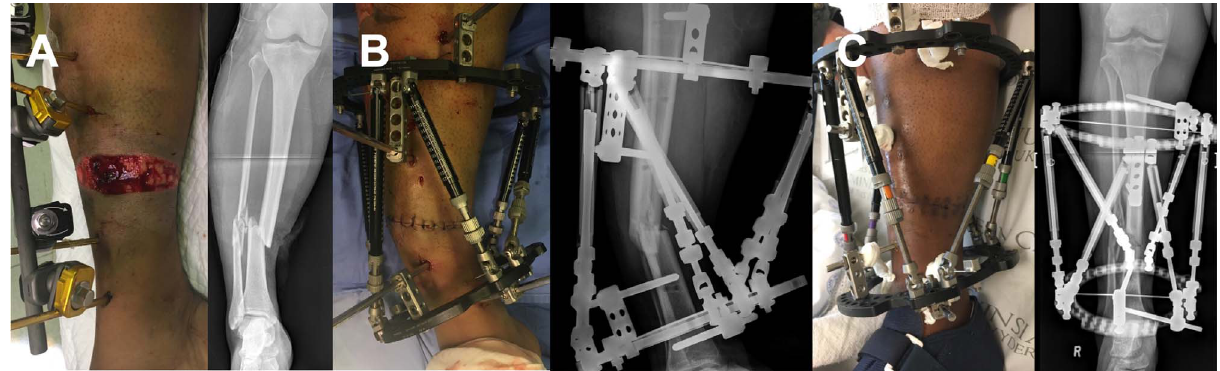
Figure 1. Fixator-assisted wound closure of an open tibial fracture . An open tibial fracture (A) was debrided and a hexapod external fi xator is mounted in angulation to facilitate healing of the skin and soft tissue without plastic surgery (B). Bony alignment can be gradually restored thereafter (C).